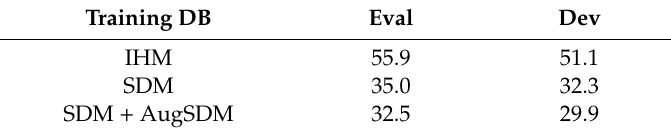
AugSDM for the evaluation and development set of